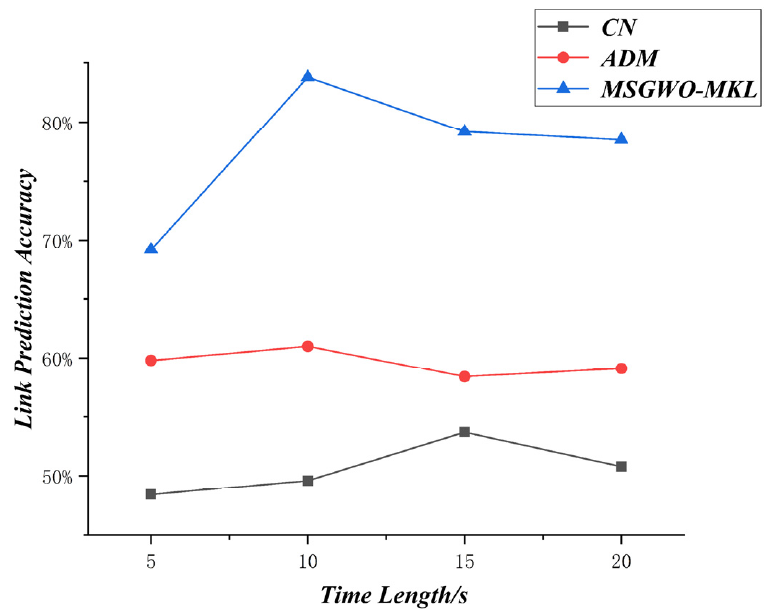
Figure 21. Variation of accuracy about time length.